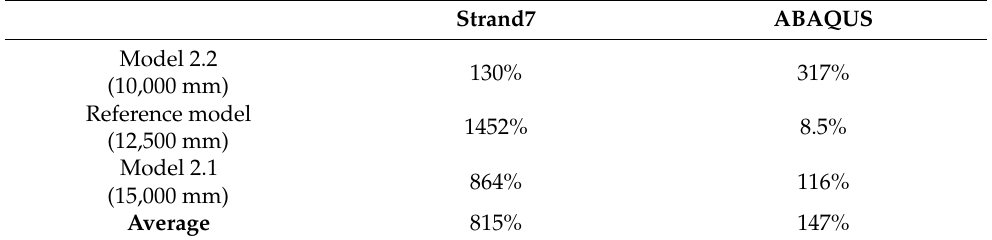
Table 19. Possible error between different approaches (change in primary beam length).